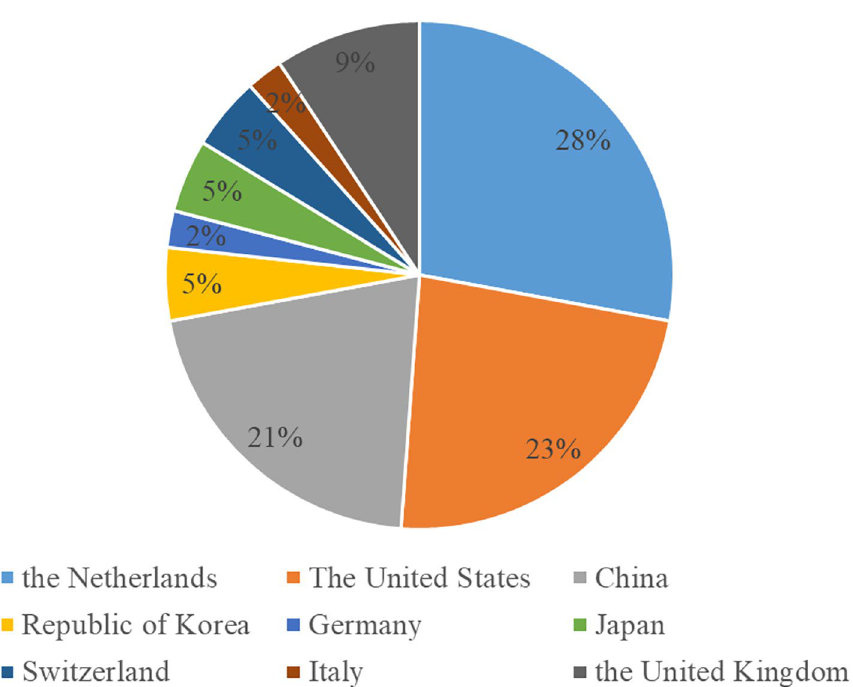
Figure 5. National distribution of PDTO